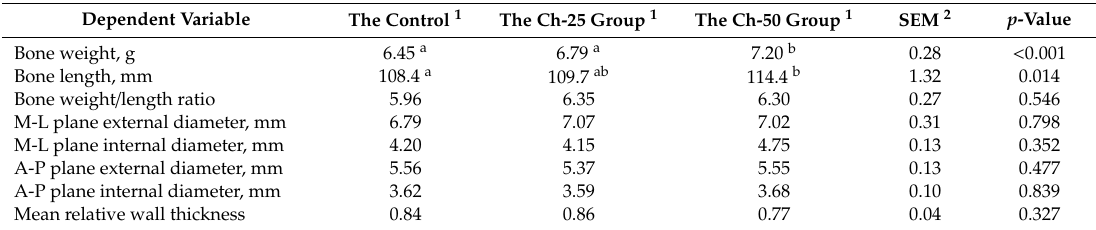
Table 3. Weight and geometrical characteristics of tibia of 16-week-old male